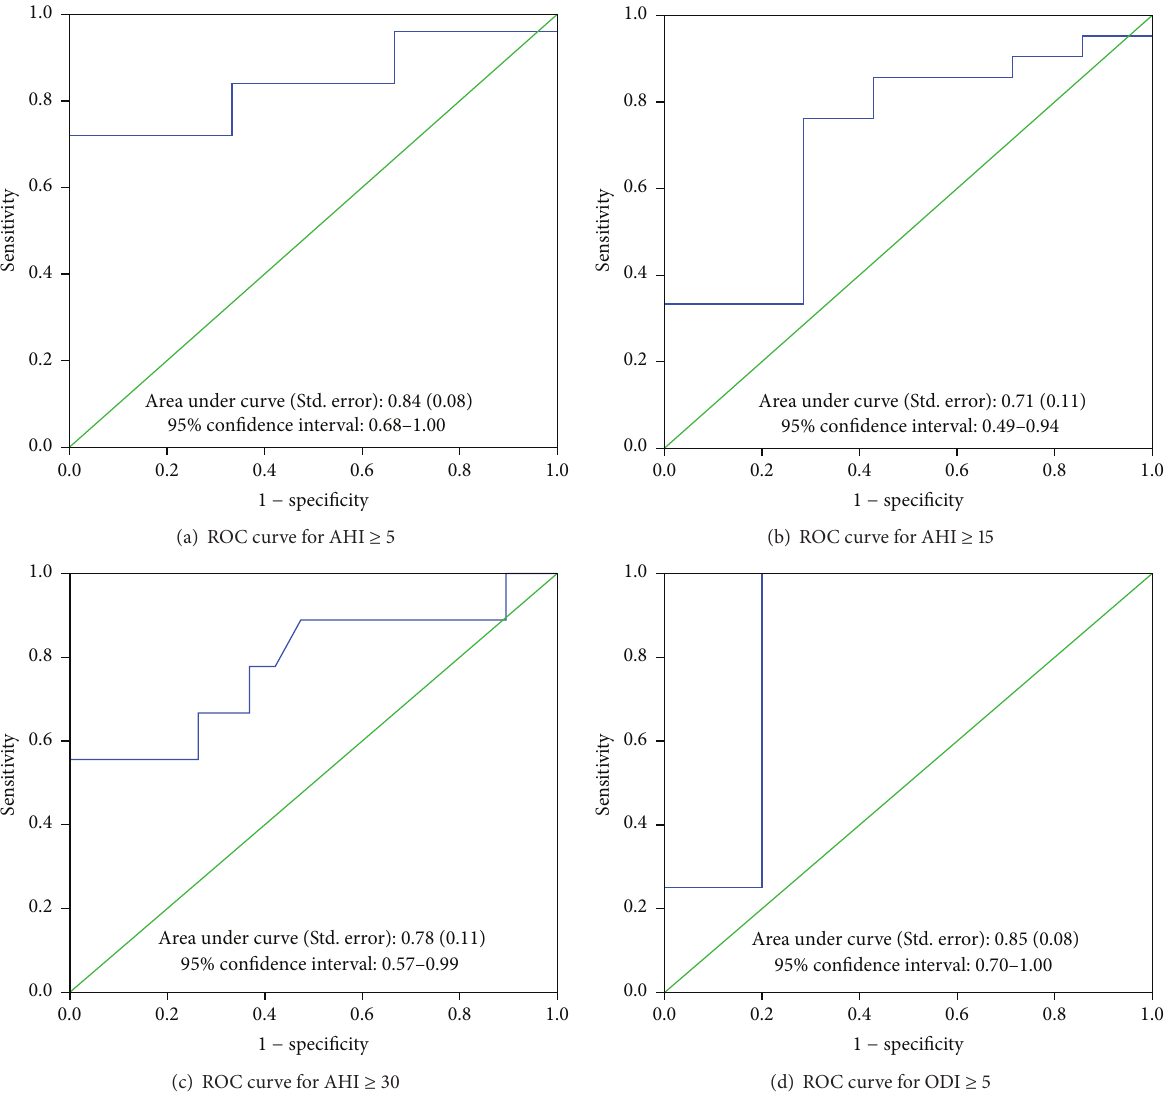
(c) ROC curve for AHI ≥ 30 (d) ROC curve for ODI ≥ 5 Figure 2: Receiver operating characteristics curve analysis of PM for AHI ≥ 5, AHI ≥ 15, AHI ≥ 30, and ODI ≥ 5. ROC referred to an AHI cut-off from PSG, which shows the sensitivity and specificity of each observed value of the RDI obtained from the PM in relation to the given PSG cut-off.